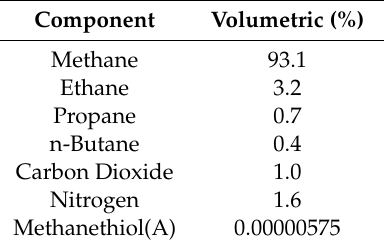
Table 4. Natural gas composition.